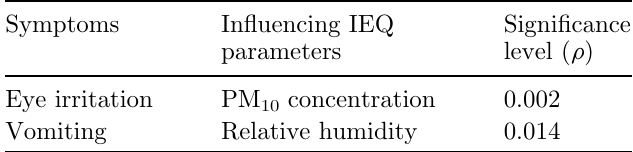
Table 14. Relationships between measured IAQ para- meters and physical health symptoms in occupants during wet